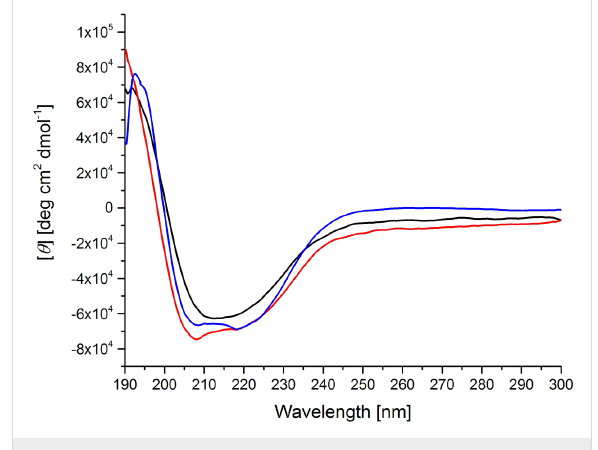
Figure 1: CD spectra of refolded catalysts 17 – 19 (red: 17 , black: 18 , blue: 19 ).